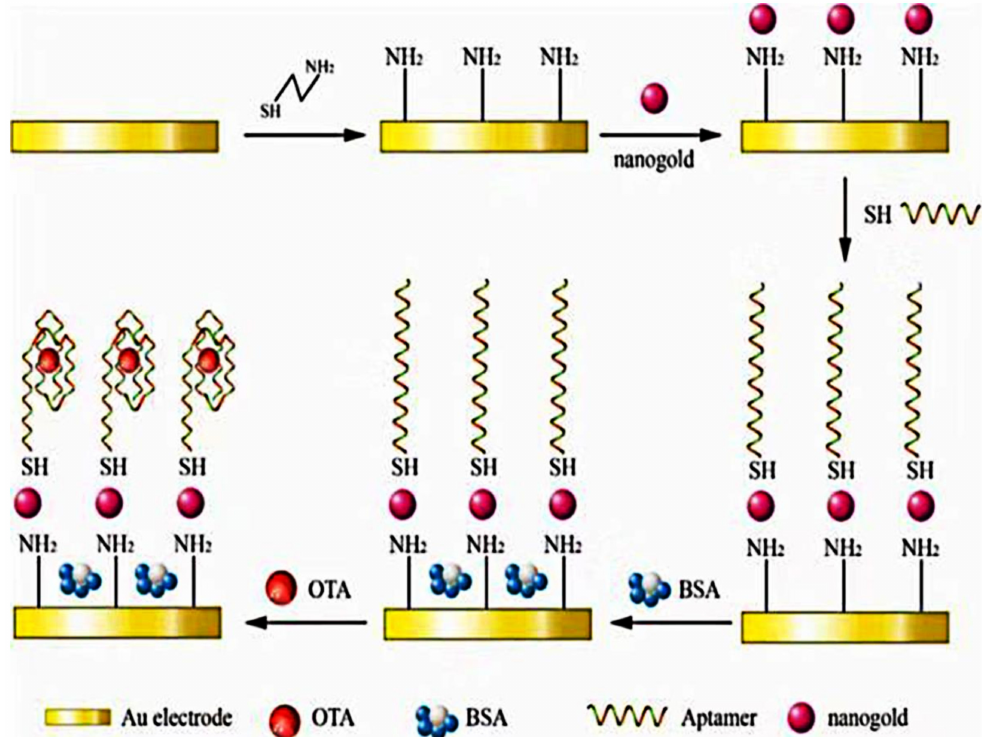
Figure 3. Schematic presentation of the fabrication steps and principle of the label-free impedimetric aptasensor. Reproduced with permission from Nan et al. [90], Toxins (Basel); published by 2019